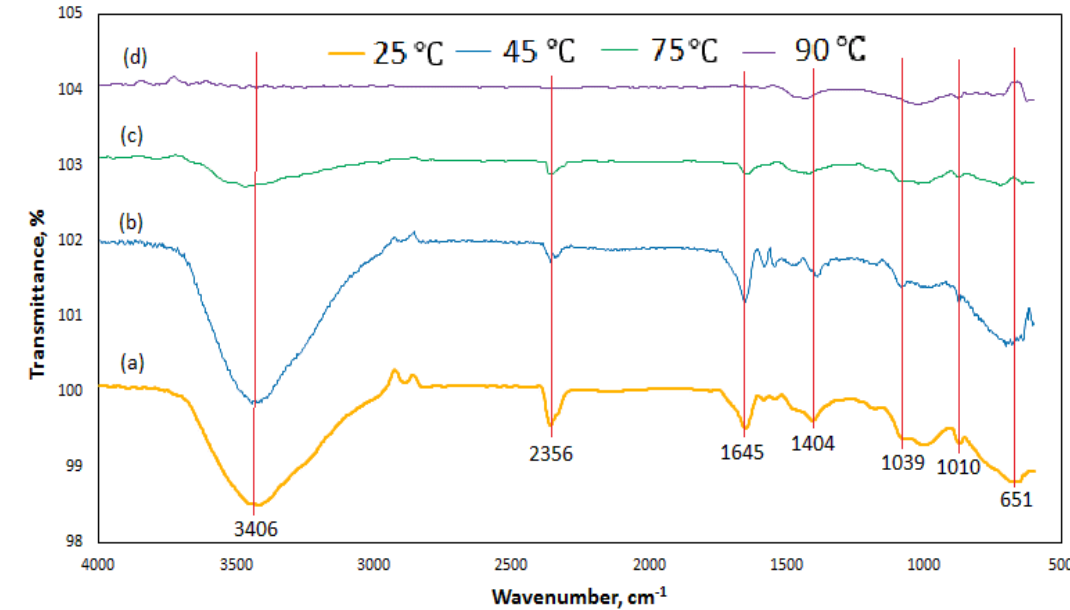
◦ C; ( b ) 45 ◦ C; ( c ) 75 ◦ C; ( d ) 90 ◦